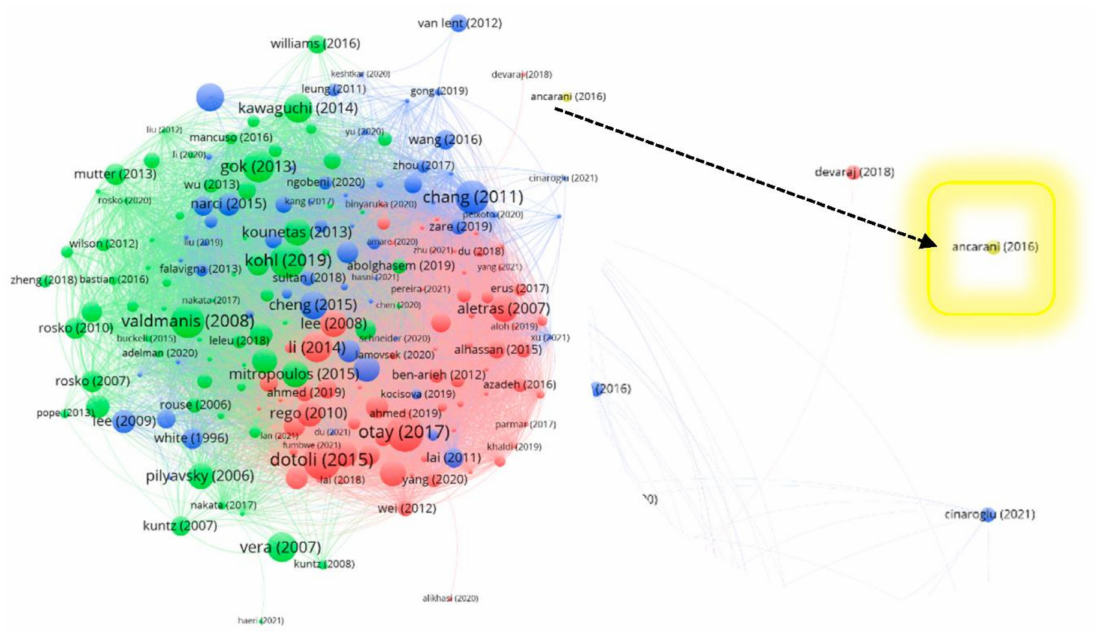
Figure 5. Distance-based network visualization for 203 Web of Science papers. The relations among publications are represented by the number of links and the dis- tance of nodes. For instance, the work of Cheng et al. (2015) [61] on evaluating the technical efficiency of Chinese county hospitals (blue node in the center of this visualization) is more related to the work of Sultan et al. (2018) [69] on measuring the efficiency of Palestinian public hospitals (smaller blue node just above the work of Cheng et al. 2015) than it is to the work of Van Lent et al. (2012) [120] on exploring improvements in patient logistics in Dutch hospitals (blue node on the extreme upper-right side of the visualization). The colors red, green and blue (and one small yellow cluster composed of only one publica- tion, Ancarani et al. (2016) [52]) indicate the groups to which a publication about hospital efficiency belongs. They are used to classify the network in the following